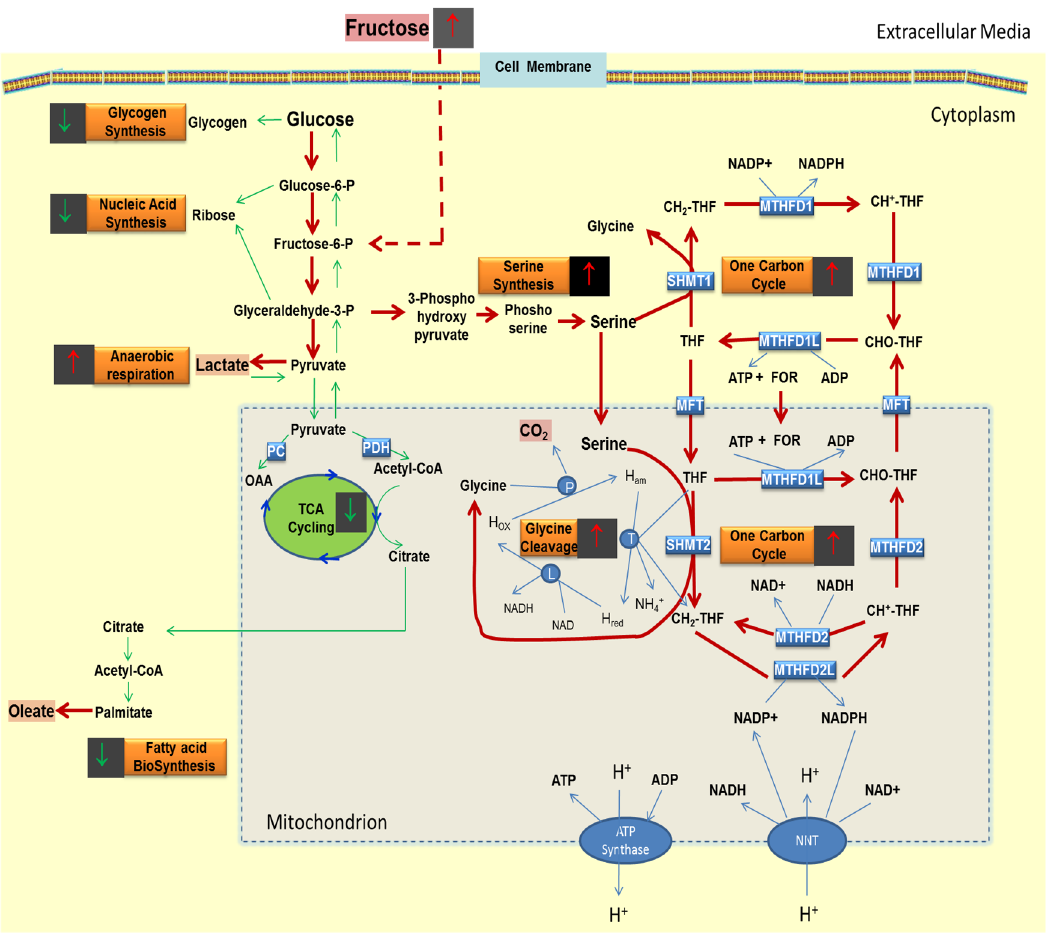
Figure 5. Schematic of the flow of glucose carbons in the presence of added fructose in adipocytes. The red arrows indicate pathways with increased flow of glucose carbons and the green arrows indicate pathways where the flow of glucose carbons are